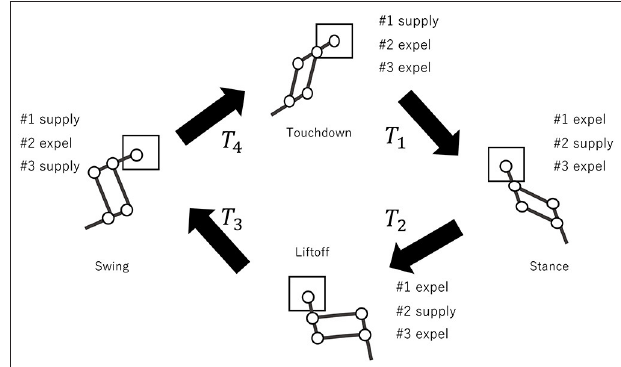
FIGURE 4 | Proposed one-leg controller. The cyclic motion of the leg is divided into four phases: touchdown phase for T 1 ms, stance phase for T 2 ms, lift-off phase for T 3 ms, and swing phase for T 4 ms.